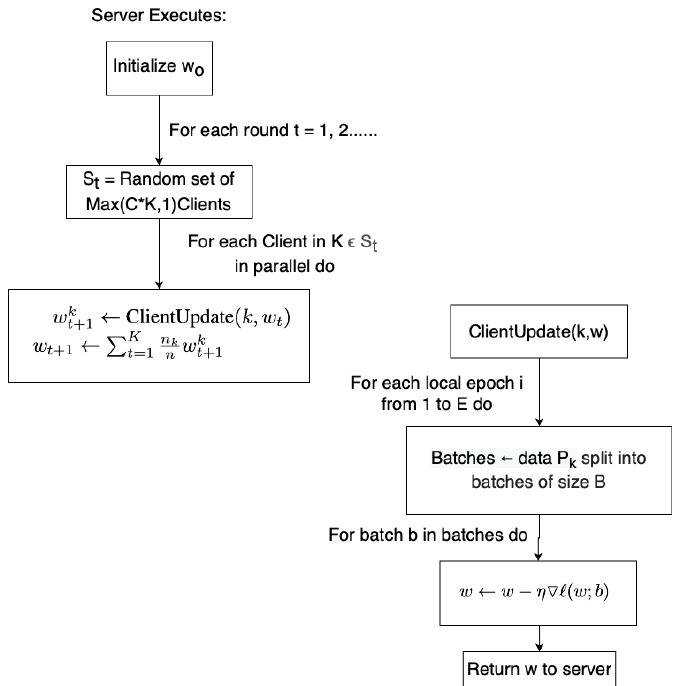
Figure 4. FedAvg algorithm proposed by McMahan et al. [142] that is widely used as a standard